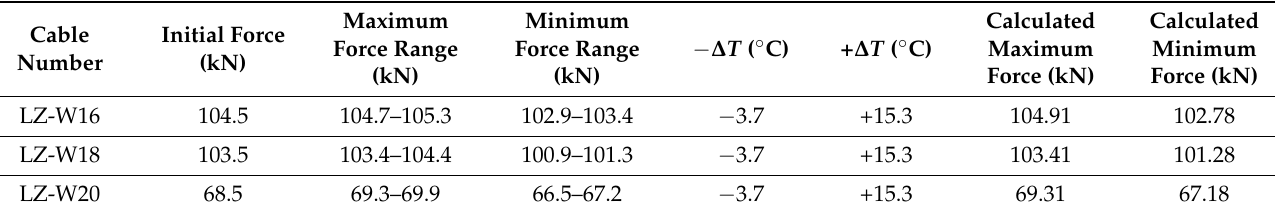
Table 7. Comparison of forces changes between measured and calculated values on the basis of the single strand FEM model.